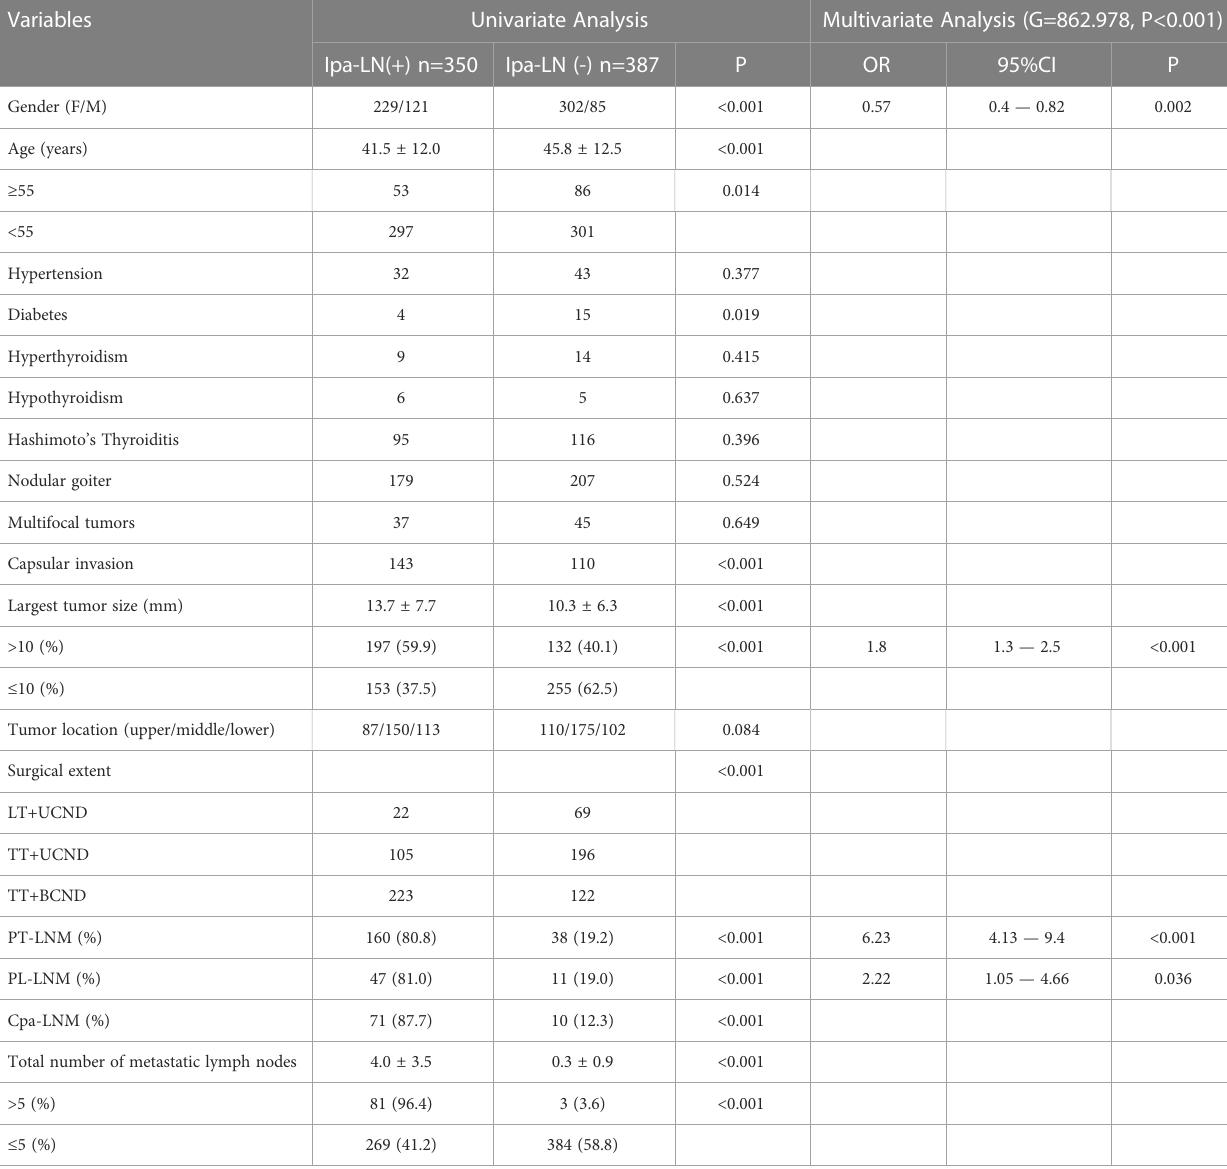
TABLE 3 The risk factors for ipsilateral paratracheal lymph node metastasis. Variables Univariate